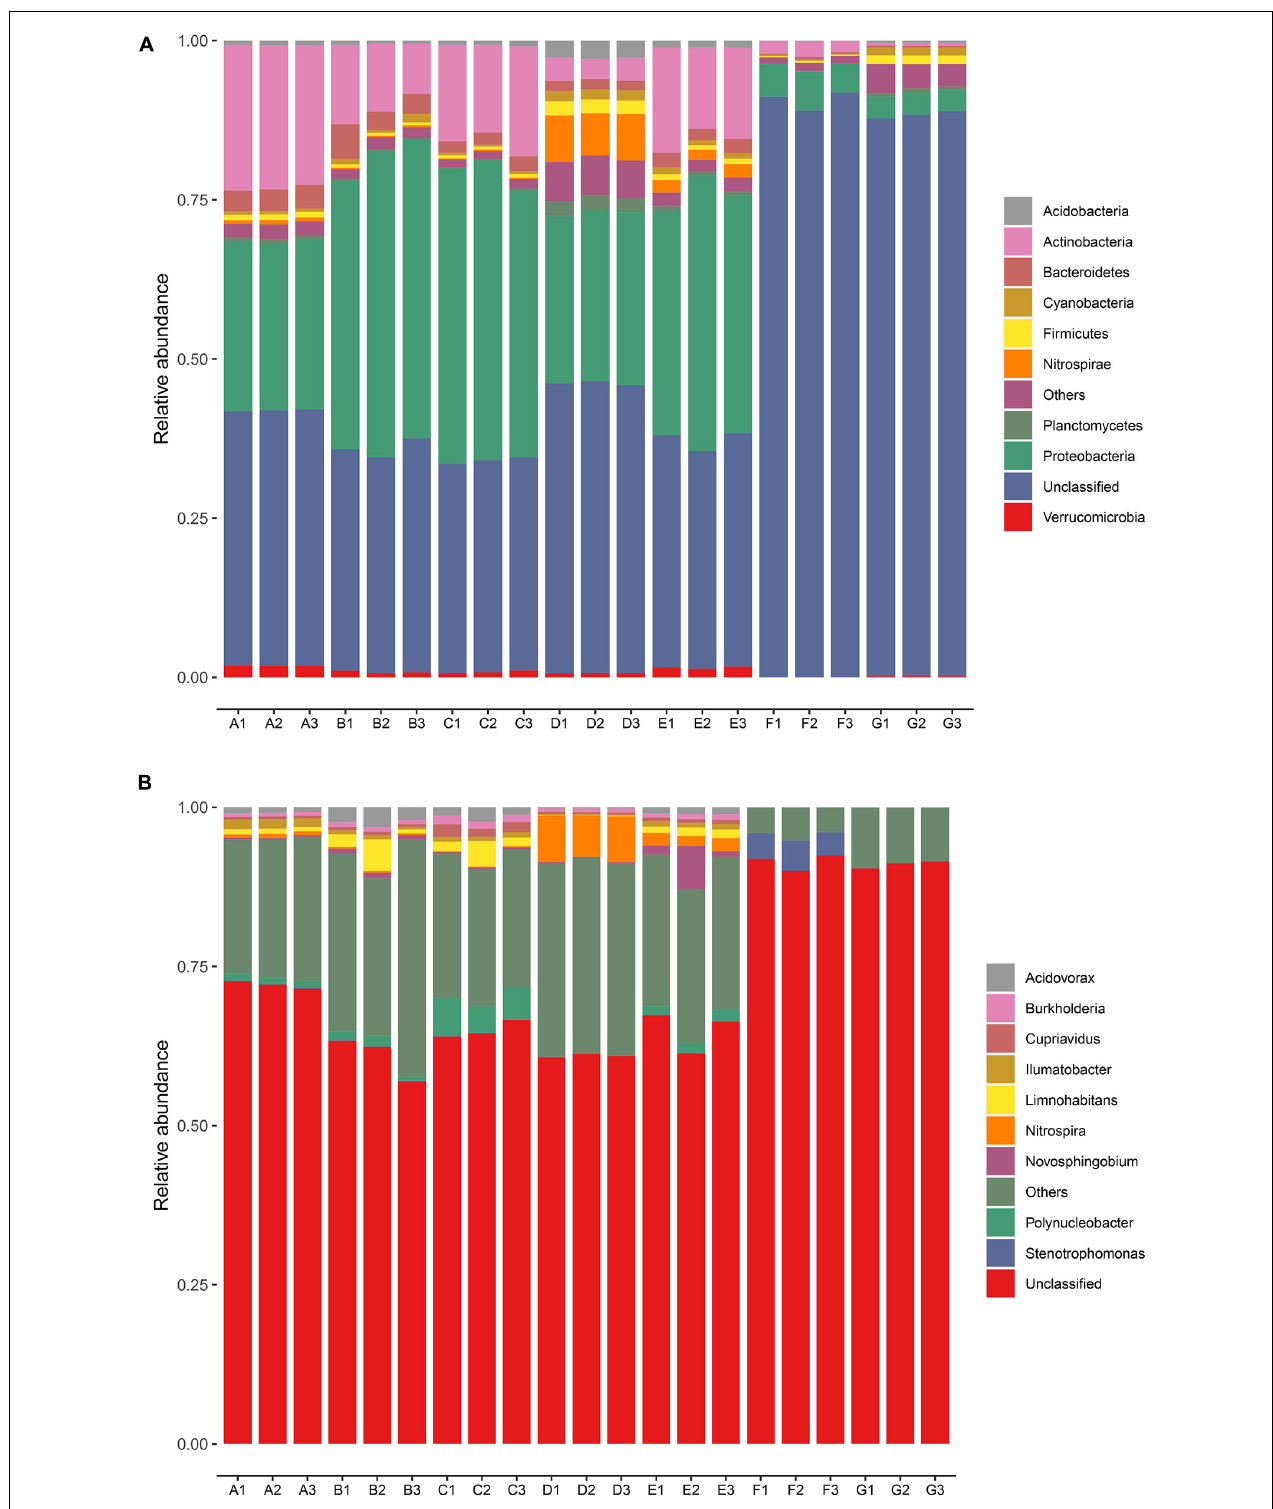
FIGURE 2 | Relative abundance of bacterial community in the DWTS bulk water and sand biofilm at the phylum level (A) and genus level (B) . Sequences that could not be classified into any known phylum or genus are assigned as unclassified bacteria. The rare species with relative abundance < 0.1% are assigned to others. A1–A3: raw water; B1–B3: flocculation tank effluent; C1–C3: sedimentation tank effluent; D1–D3: quartz sand; E1–E3: sand filter effluent; F1–F3: chlorine-disinfected water; G1–G3: tap water. Three samples were taken from each sampling